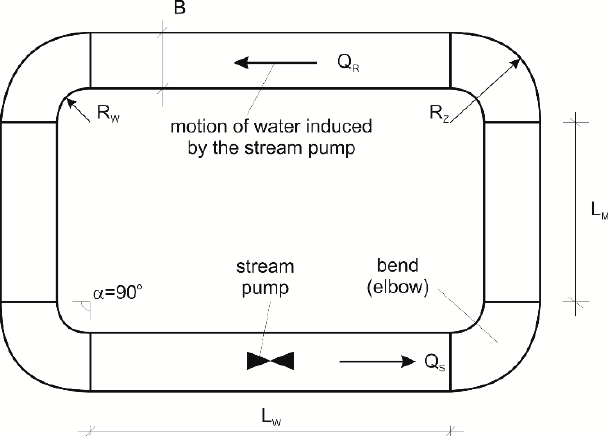
Figure 1. Generalized shape of a circulating tank.